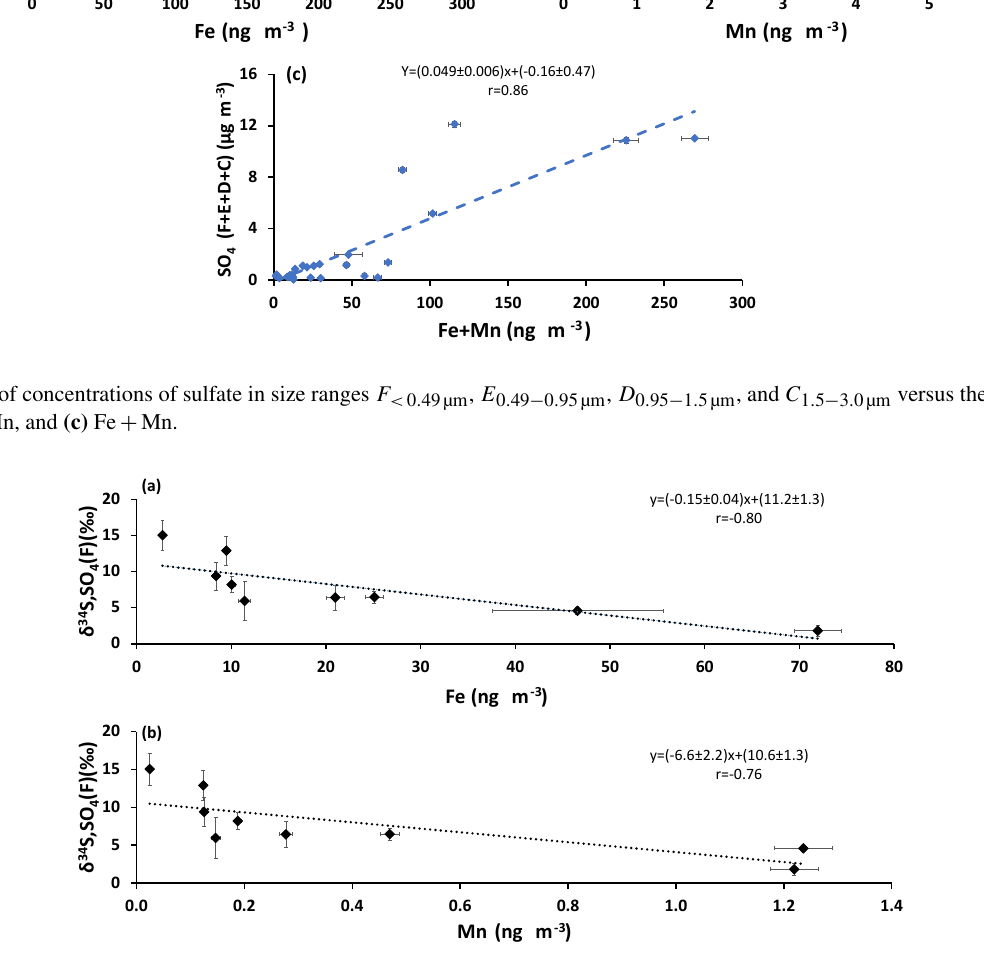
grated OH production rate, suggesting that another oxidation pathway for SO 2 was active during daytime. One likely path- way is oxidation of SO 2 by Criegee